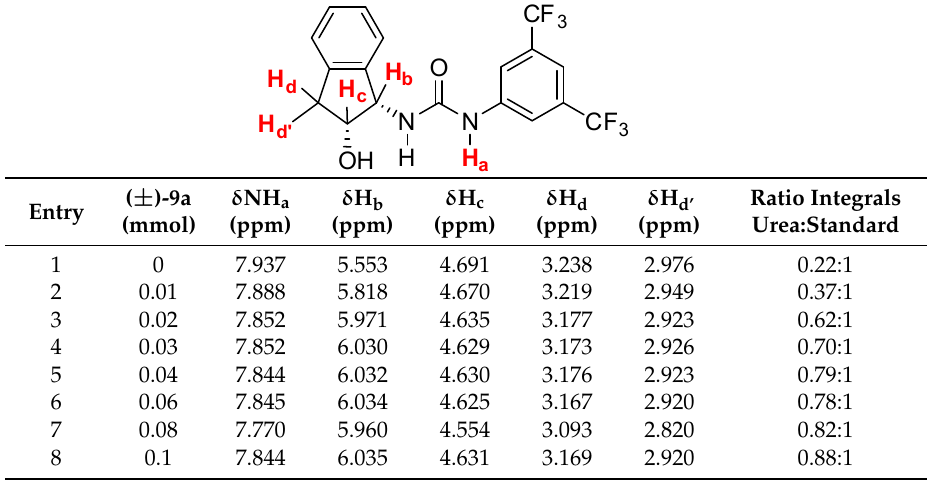
Table 4. Effect of the acid on the 1 H NMR signals of the urea catalyst. a